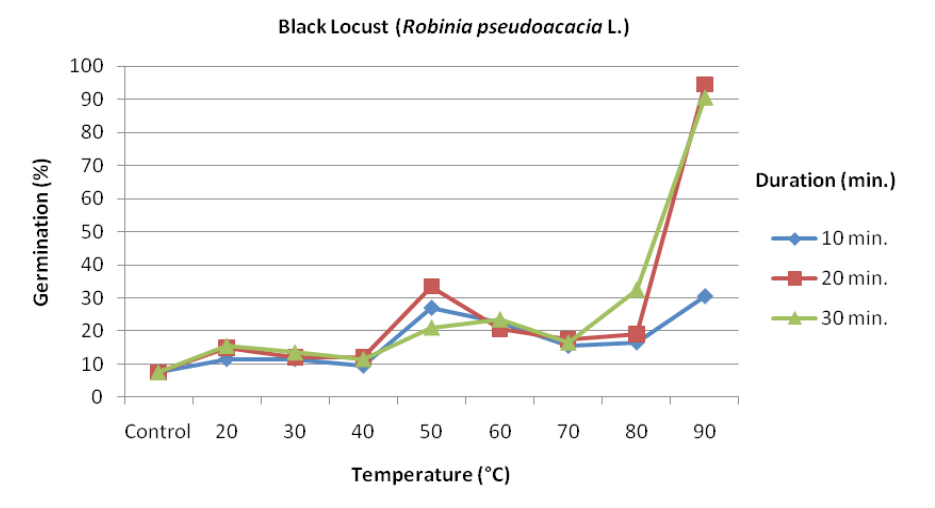
Fig. 1. The effect of different temperatures and durations on germination rates of black locust ( Robinia pseudoacacia L.)